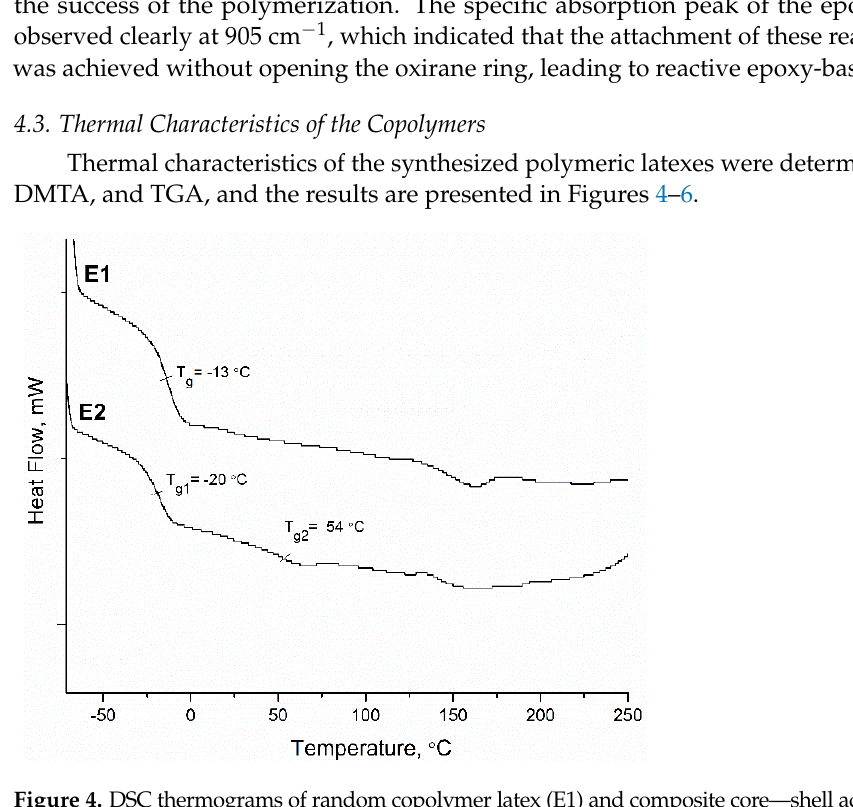
Figure 3. ATR — FTIR spectra of the synthesized latexes (E1 and E2) and pure monomers. Figure 3. ATR—FTIR spectra of the synthesized latexes (E1 and E2) and pure monomers.